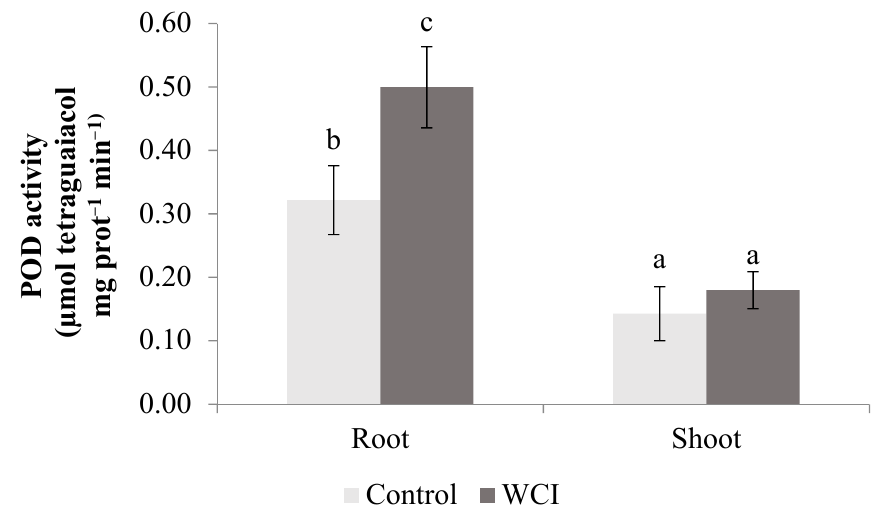
Figure 8. The effect of woolly cupgrass infestation (WCI) on the POD activity of maize 21 d.a.s. (values represent means ± SD, n = 5). Small letters (a, b, c) show significant differences between treatments based on independent t -test ( p < 0.05).